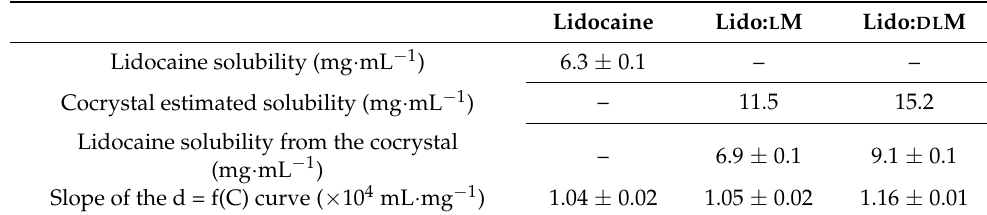
Table 5. Data calculated from the density = f(concentration) curves at 25 ◦ C and pH 7.2. The solubility of each menthol compound conducted to aqueous concentrations lower than the limit of detection of the density device. For each cocrystal, the slope of the d = f(C) straight line was determined in the 0–3 mg · mL − 1 concentration